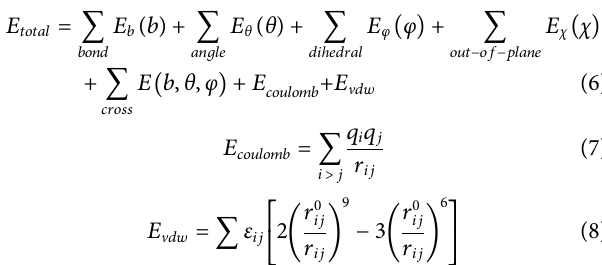
Figure 1 ; Supplementary Table S1 showed the different isotherm models fi t for adsorption of fi ve surfactants onto carbonate rock at 298 K. The Q m parameter of the CTAB, SDS, TX-100,